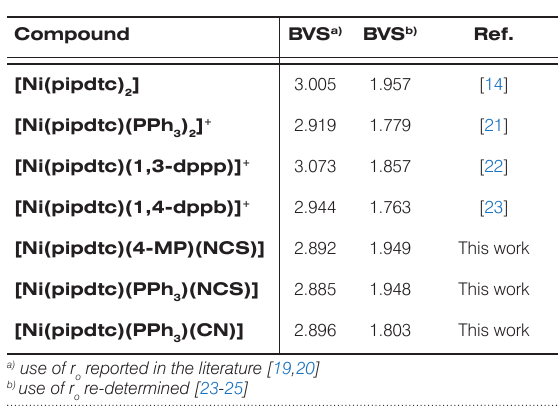
a marginally significant higher trans influence compared to NCS - . The thioureide C—N distances in the mixed ligand complexes are relatively very short compared to the parent compound due to the mesomeric drift of electron density towards the metal. The Ni—N—C from linearity to a larger extent compared to that observed in ( 1 ) (176.3(3)°) due to the steric effect of the 4-methyl group However, the presence of π-acids, PPh and 4-MP alleviate the electron 3 density on the nickel atom in solution and, hence the complexes are much less compared to the parent NiS 4 chromophore.